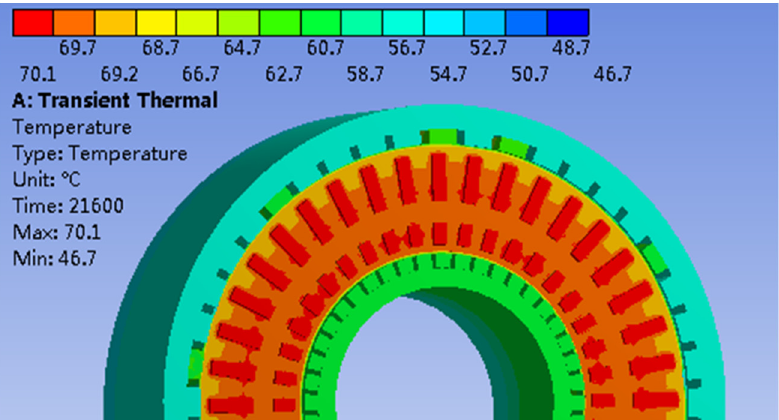
Figure 12. The temperature field distribution of 1 kW